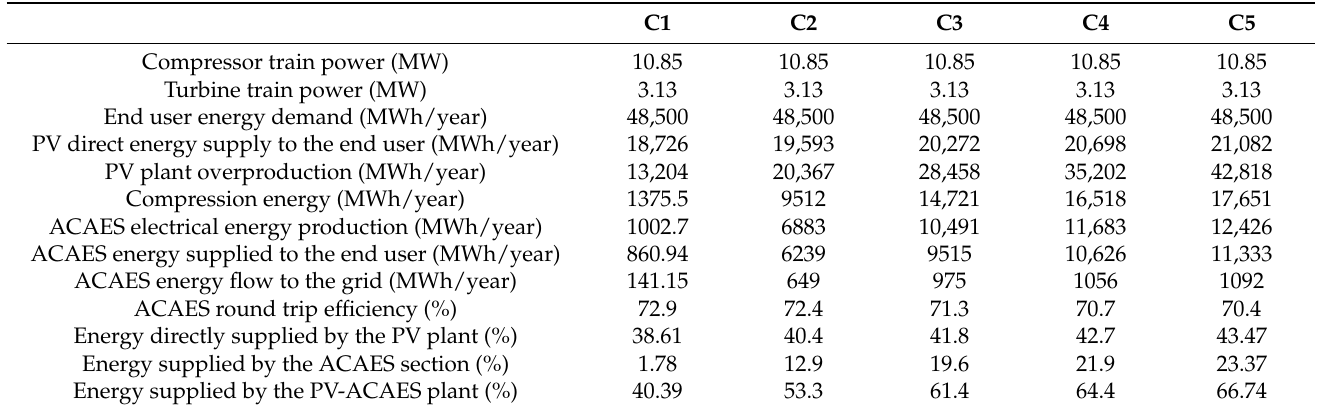
Table 4. Main performance parameters of the integrated PV-ACAES